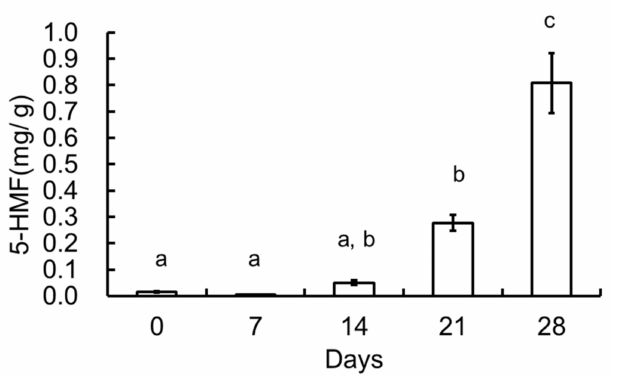
Figure 8. Content of 5-hydroxymethyl furfural (5-HMF) in black garlic extract (0, 7, 14, 21, and 28 days of heating). Values are mean ± SE(n = 3). Values not sharing the same character (a, b, and c) are significantly di ff erent at p <